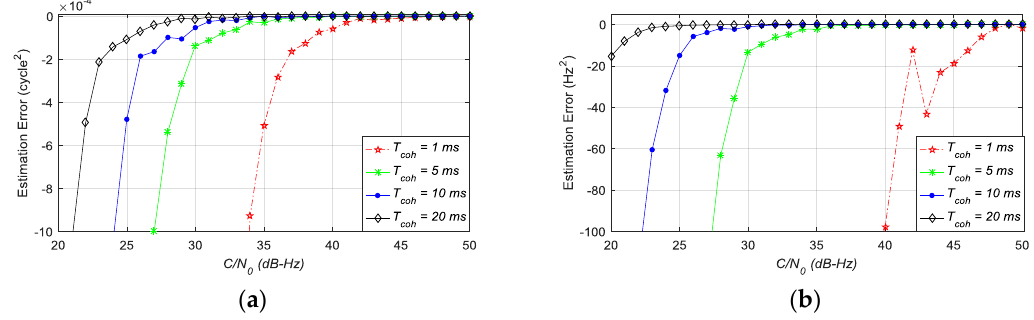
Figure 8. ( a ) The error of estimation noise variance of Equation (18) for ATAN discriminator; ( b ) The error of estimation noise variance of Equation (19) for ATAN2 discriminator.